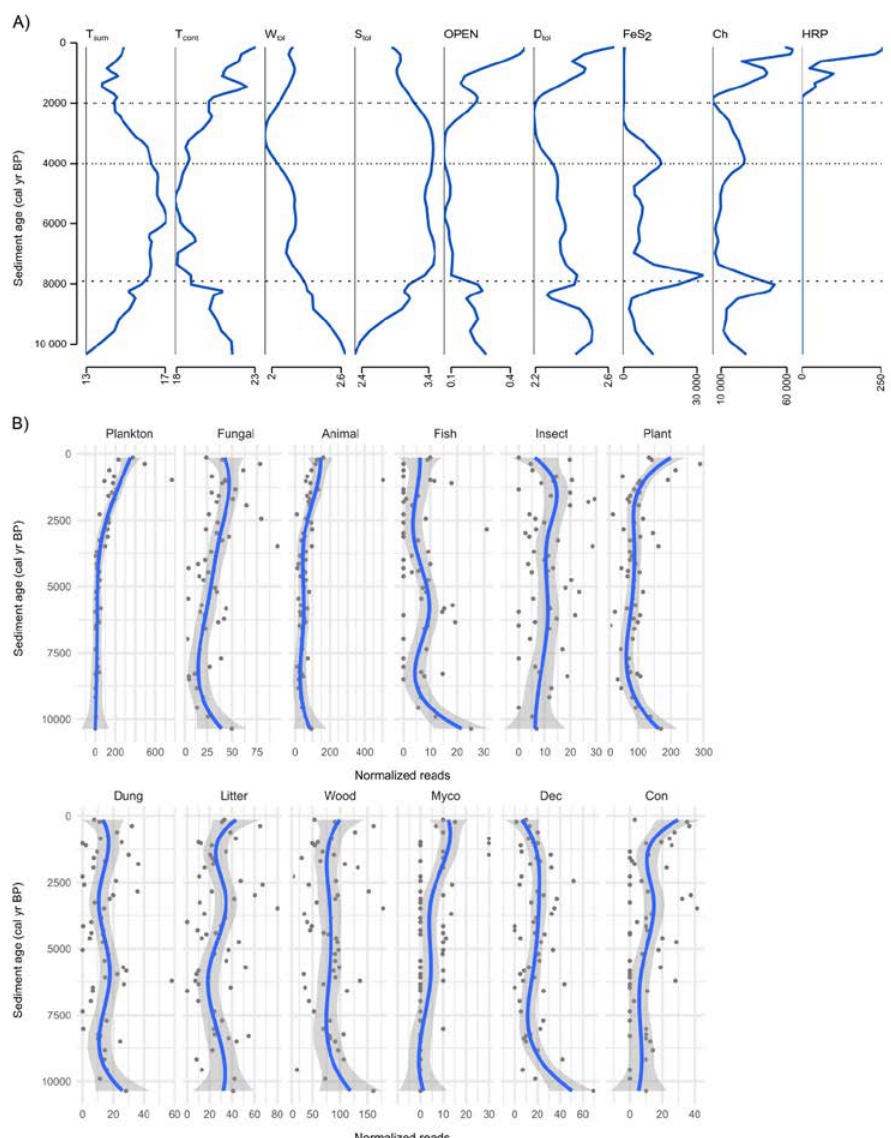
Figure 5. The dynamics of ( A ) environmental paleoproxies and ( B ) ecophysiological groups of fungi over the last 10.5 kyr, modeled using GAM with formula = y ~ splines::bs(x, 5). Assigned ecophysiological roles of fungi abbreviations: plankton parasites (Plankton), animal pathogens (Animal), fish pathogens (Fish), insect parasites (Insect), fungal parasites (Fungal), plant pathogens (Plant), dung saprotrophs (Dung), litter saprotrophs (Litter), wood saprotrophs (Wood), mycorrhizal fungi (Myco), deciduous trees related fungi (Dec), conifers related fungi